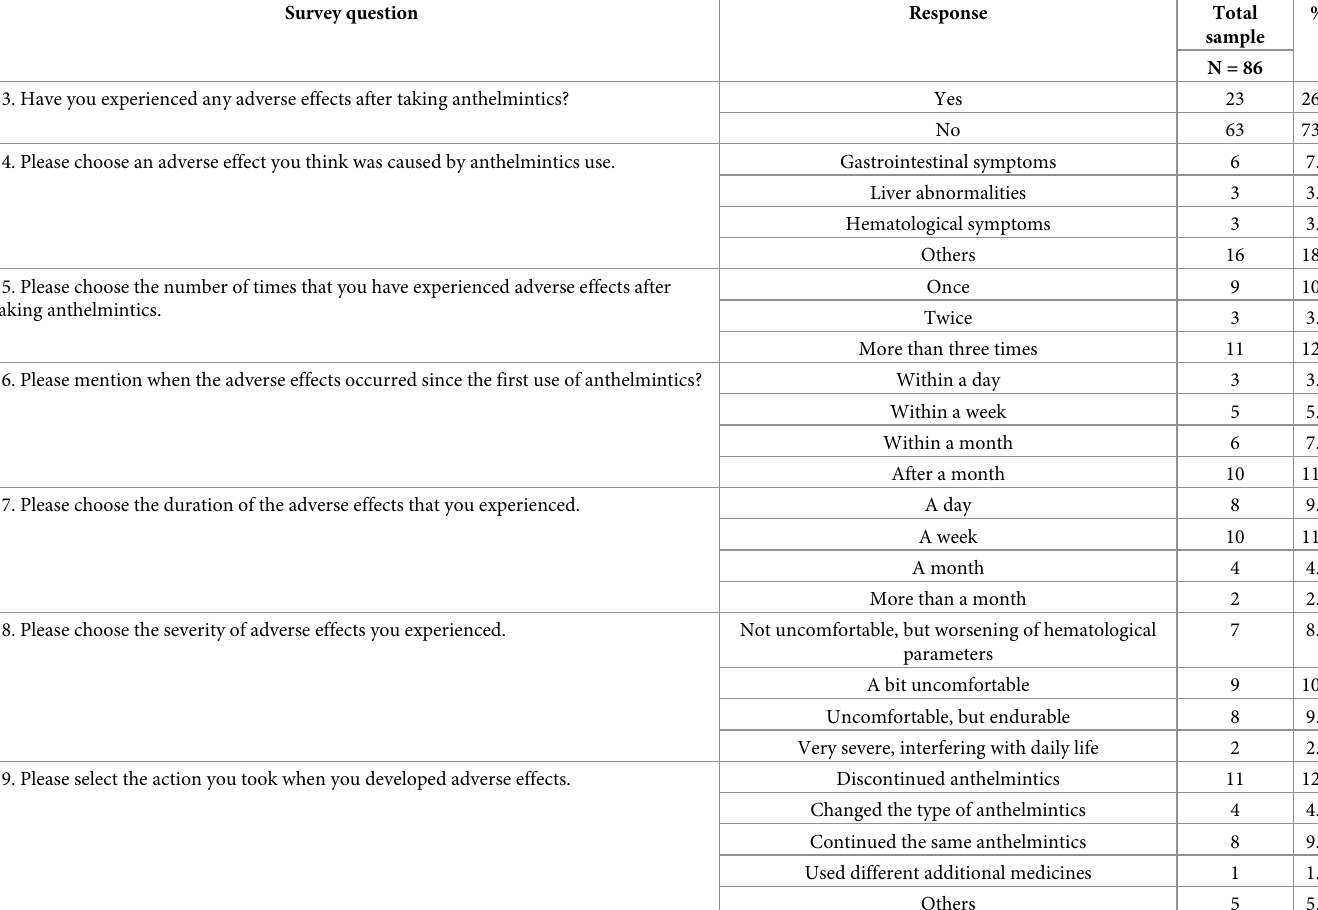
Table 4. Perceptions on adverse effects of